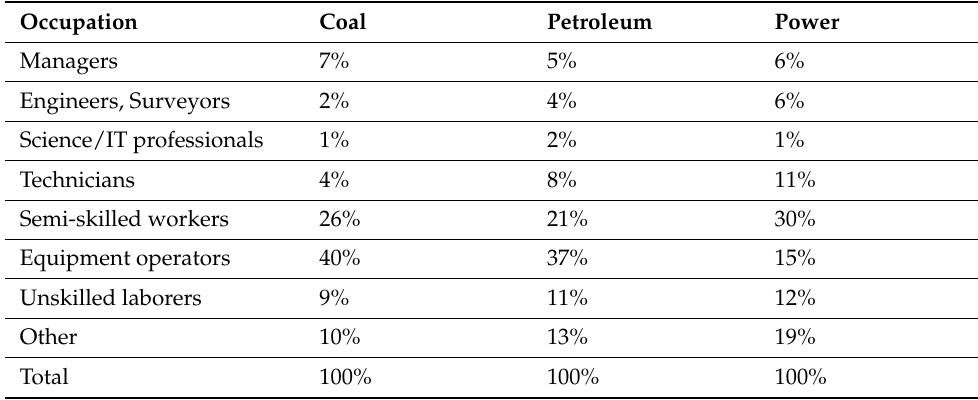
Table 1. Distribution of total workforce across groups of occupations, average, 2010–2020. Occupation Coal Petroleum